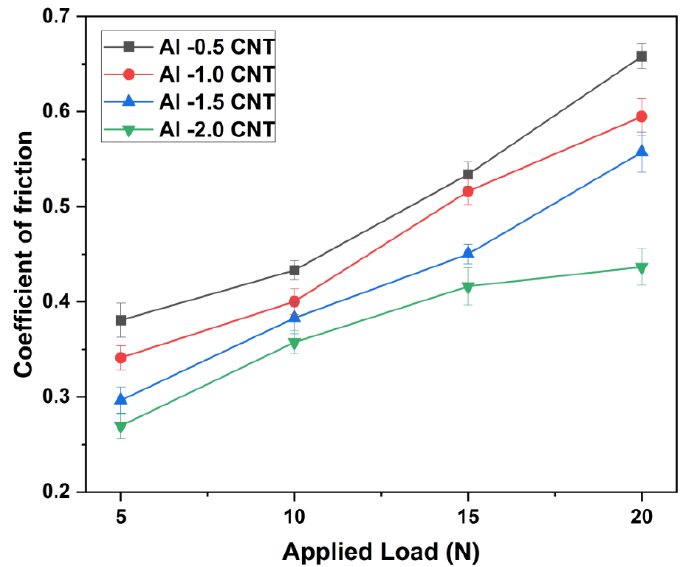
Figure 8. Effect of applied load on coefficient of friction for composite samples prepared with different CNT content in dry sliding condition.